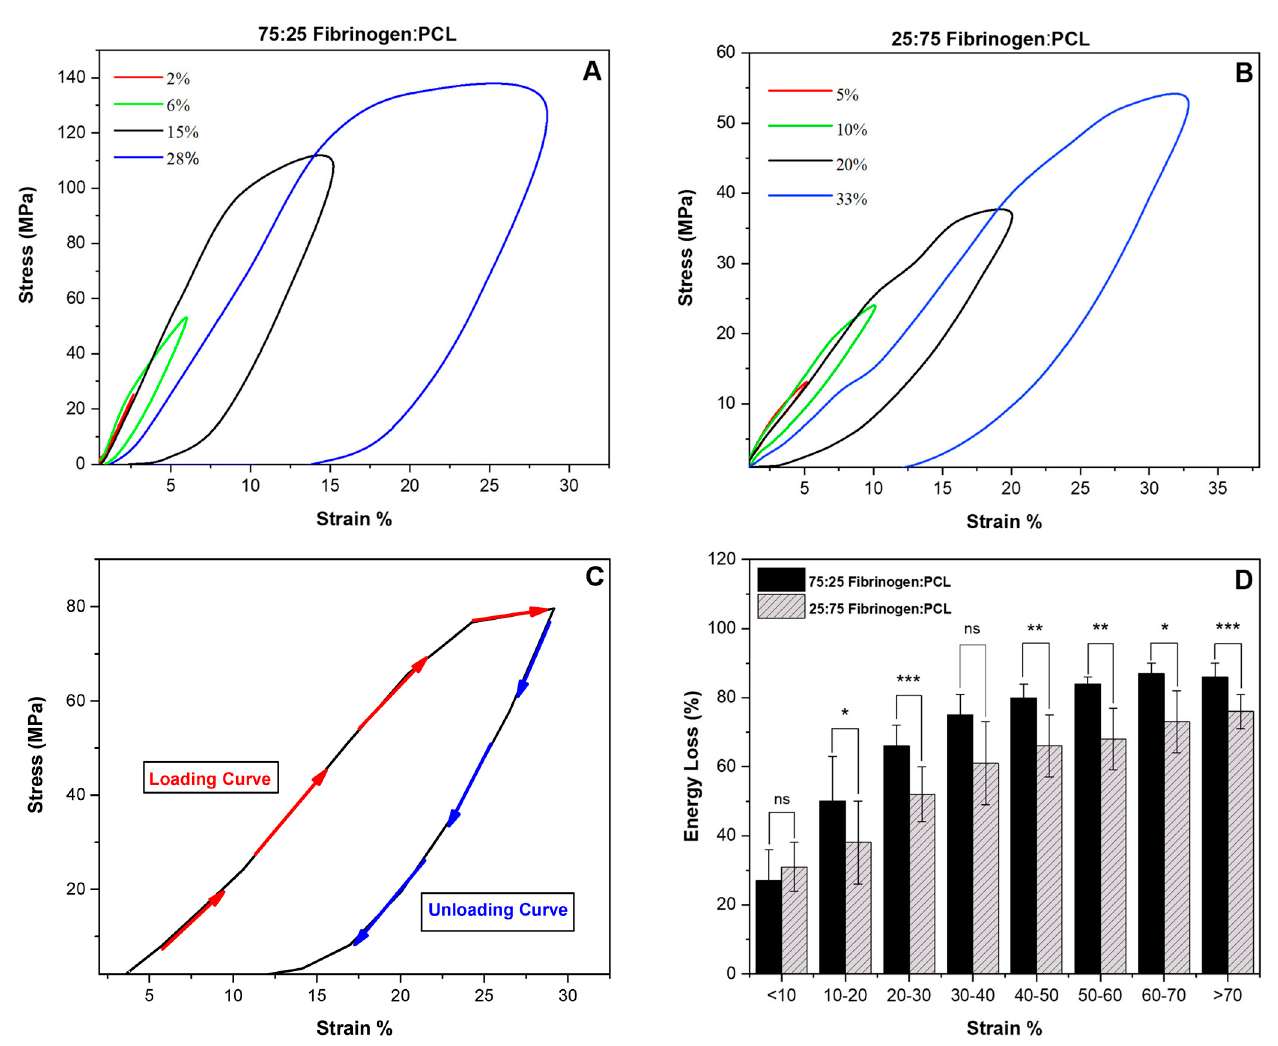
Figure 5. Stress and strain curves for four pulling cycles of fibrinogen:PCL fibers. ( A ) 75:25 ratio, ( B ) 25:75 ratio. The fiber was stretched to different strains until a permanent deformation occurred. The first and second pulls (red and green curves) the stress and strain returned to zero simultaneously. The third pull (black curve) represents the fiber prior to deformation, and the fourth pull (blue curve) represents the fiber after the permanent deformation. ( C ) Plot of a single stress–strain curve of electrospun fiber. The area enclosed by the loading and unloading curves is proportional to the amount of energy lost during the cyclical stretching process. ( D ) Energy vs. strain for fibers with different ratios. Error bars represent the standard deviation of the mean. * indicates a p -value < 0.05; ** indicates a p -value < 0.01; *** indicates a p -value < 0.001.